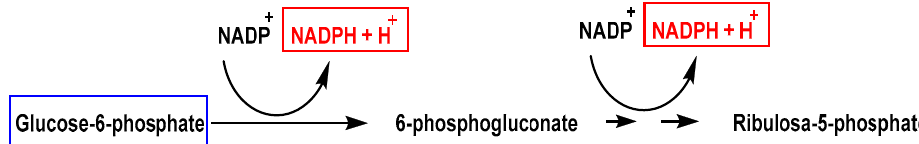
Figure 11. Formation of NADPH molecule in the transformation of glucose-6-phosphate into ribulose 5-phosphate.